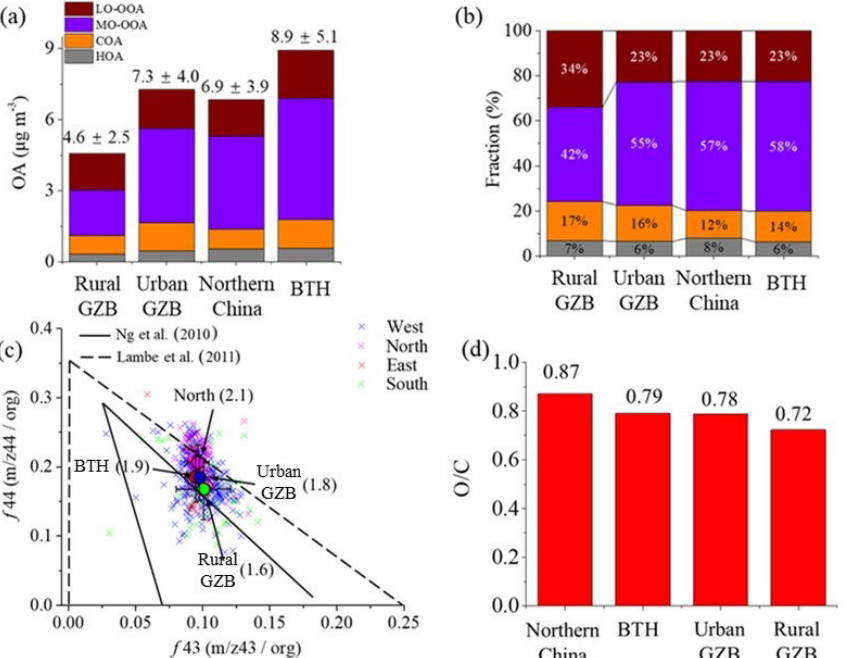
Figure 6. The comparison of (a) the mass concentration and (b) fractions of organic aerosol. (c) Scatter plot of f 44 vs. f 43 in four transport directions. The triangles from Ng et al. (2010) and Lambe et al. (2011) are drawn as a solid line and a dotted line, respectively. (d) The O / C ratio in four transport directions.